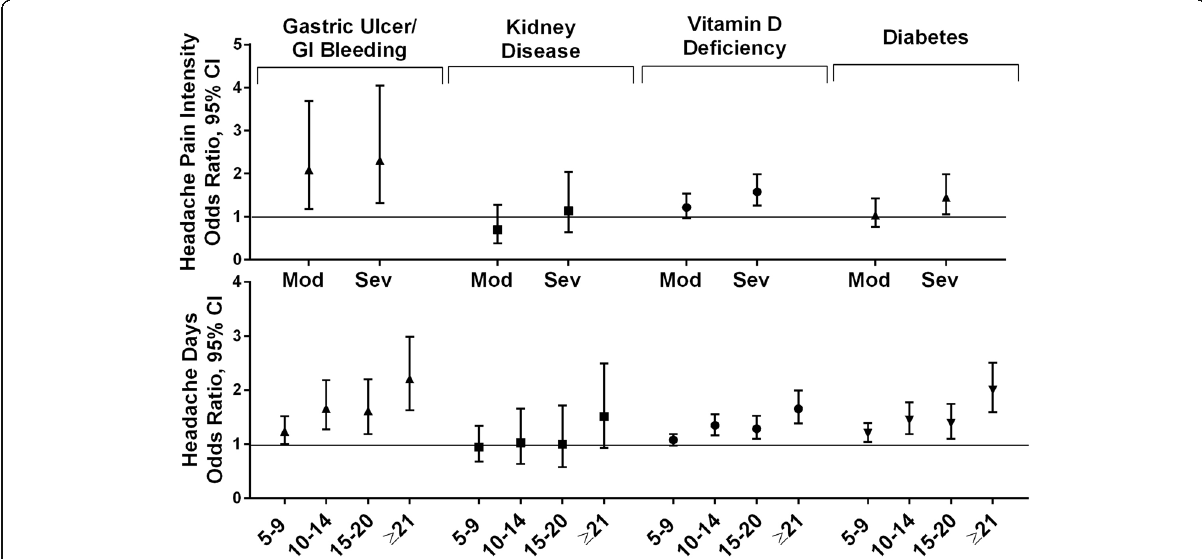
Fig. 4 Among persons with migraine the odds ratios (and 95% CI) for each comorbid general medical condition*. Fully adjusted models with sociodemographic characteristics (age, gender, Hispanic origin, race, marital status, employment, household income), headache pain intensity and headache frequency. Reference groups are low headache pain intensity for headache pain intensity and low frequency headache (1 – 4 MHDs)